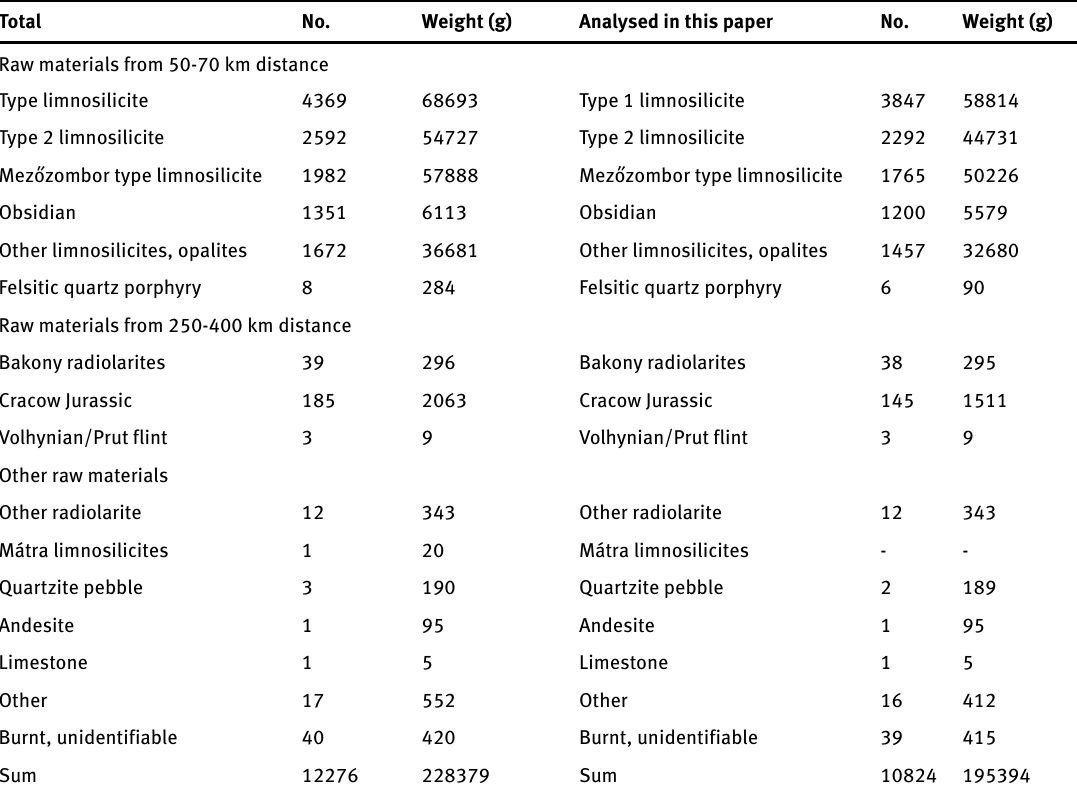
Table 1: Raw material composition at Polgár-Csőszhalom. Total No. Weight (g) Analysed in this paper No. Weight